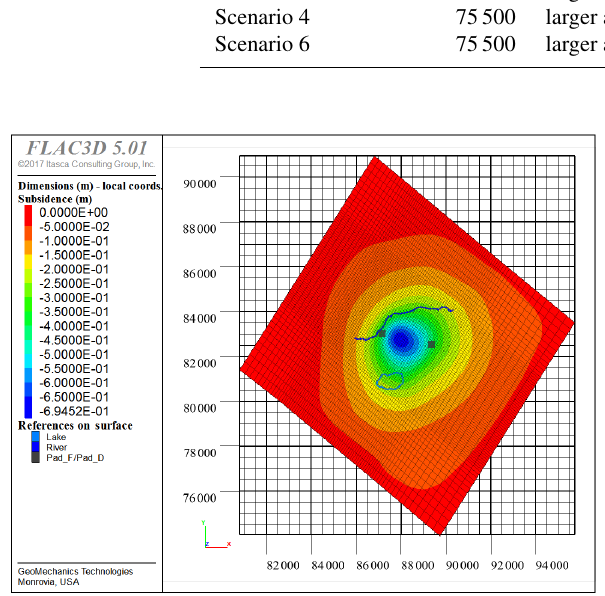
Figure 6. Surface displacement results for base case over period years 2015–2064.